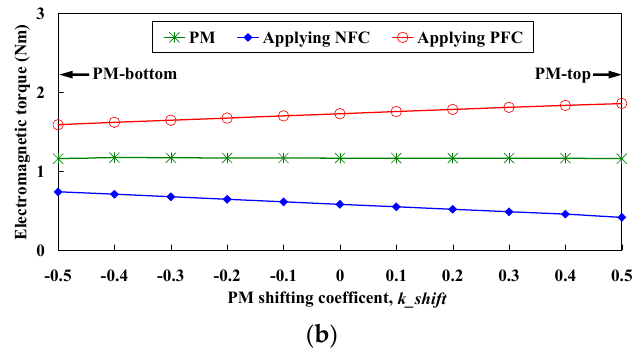
Figure 11. Influences of k shift when Ferrite is adopted (PFC and NFC indicate positive field current and negative field current, respectively). ( a ) Variation of no ‐ load coil ‐ A1 flux; ( b ) Variation of torque values when RMS 98AT per half armature slot is applied.